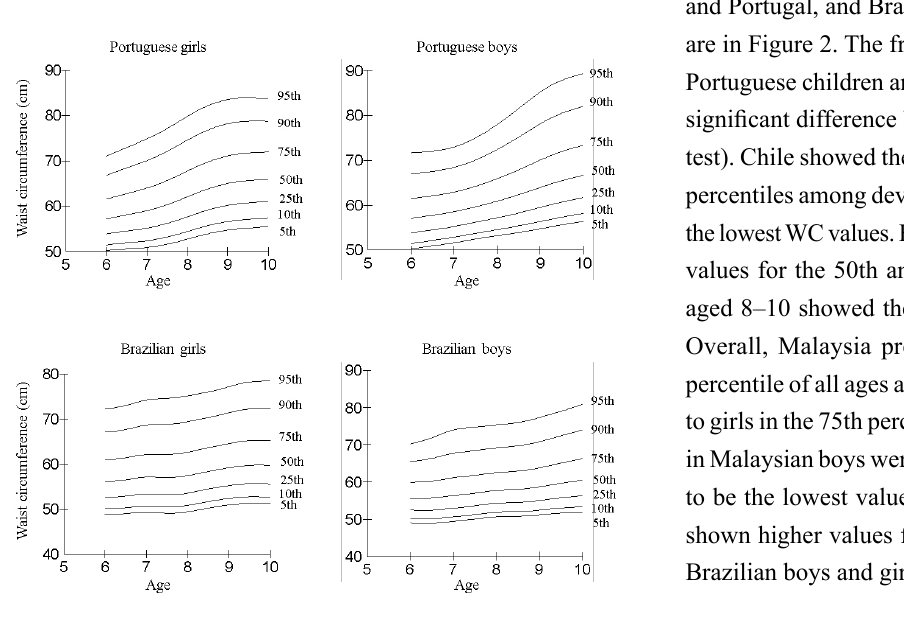
Figure 1: Smoothed reference curves for the 5th, 10th, 25th, 50th, 75th, 90th and 95th percentiles of waist circumference in Portuguese and Brazilian girls and boys aged 6–10 years